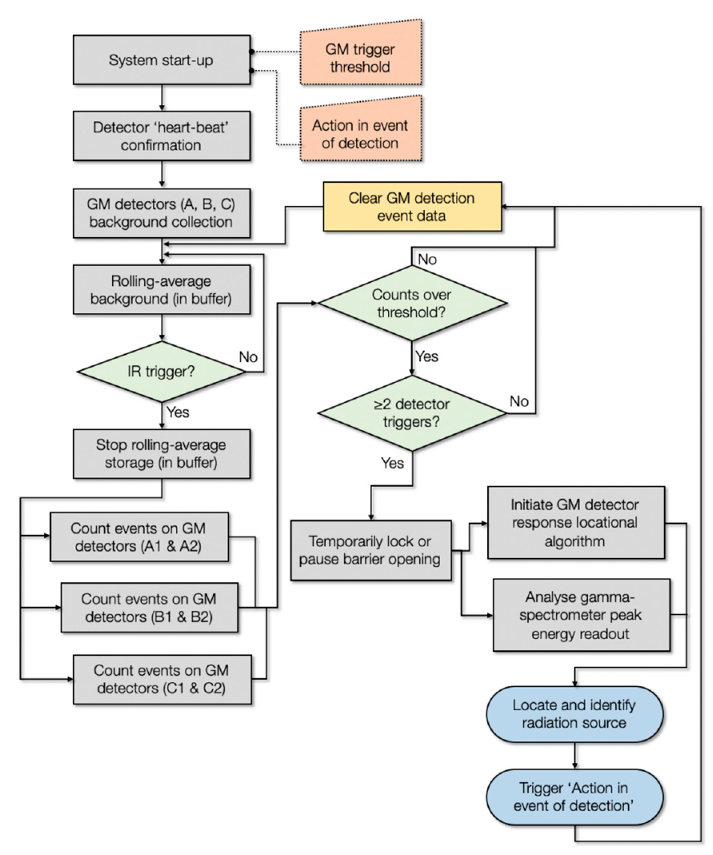
Figure 3. Flowchart of the Project Gatekeeper detection and location algorithm.